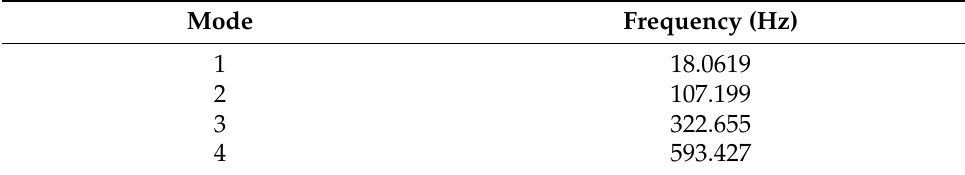
Figure 7. Vibration shape for ( a ) Mode 1, ( b ) Mode 2, ( c ) Mode 3, and ( d ) Mode 4. Table 1. Natural frequencies of the Pinus wood